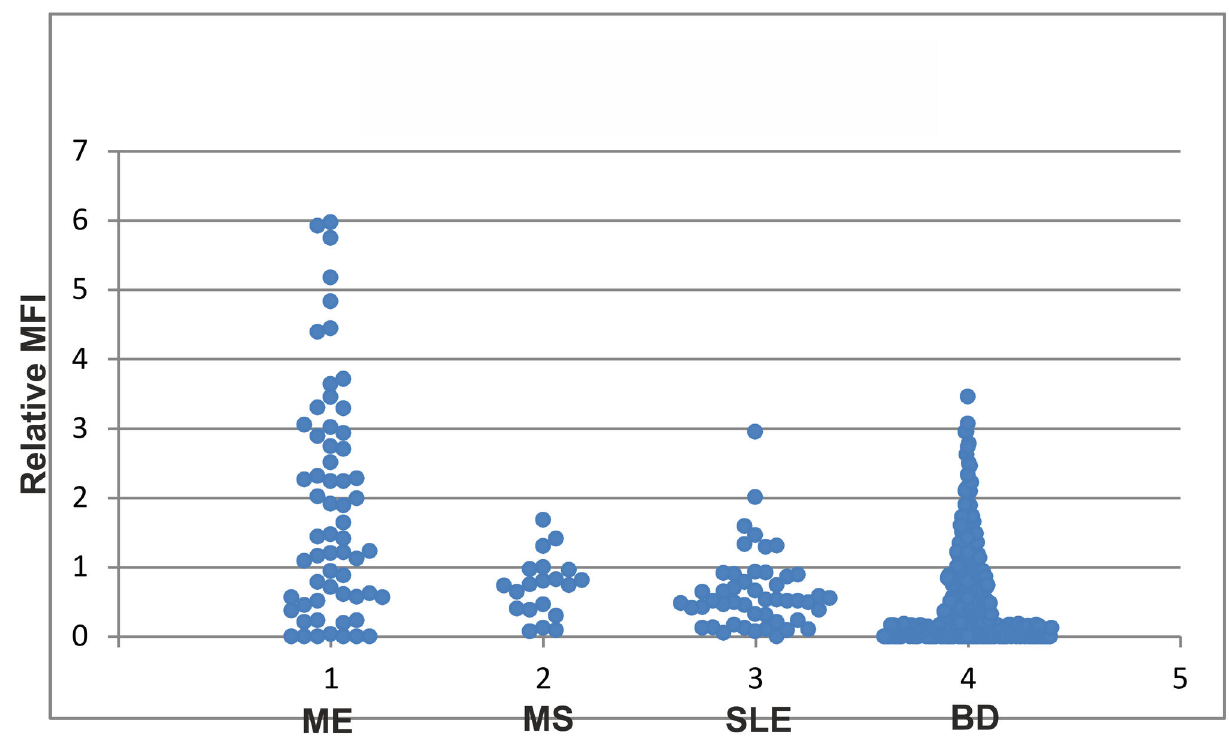
Figure 5. Needle plot of the relative MFI of the Chlamydia peumoniae G20c homolog (peptide 12) and the ME, MS, SLE and BD samples in the Evaluation set. Relative MFI were calculated by division of the MFI for each sample with the MFI of a pool of 69 ME samples, diluted